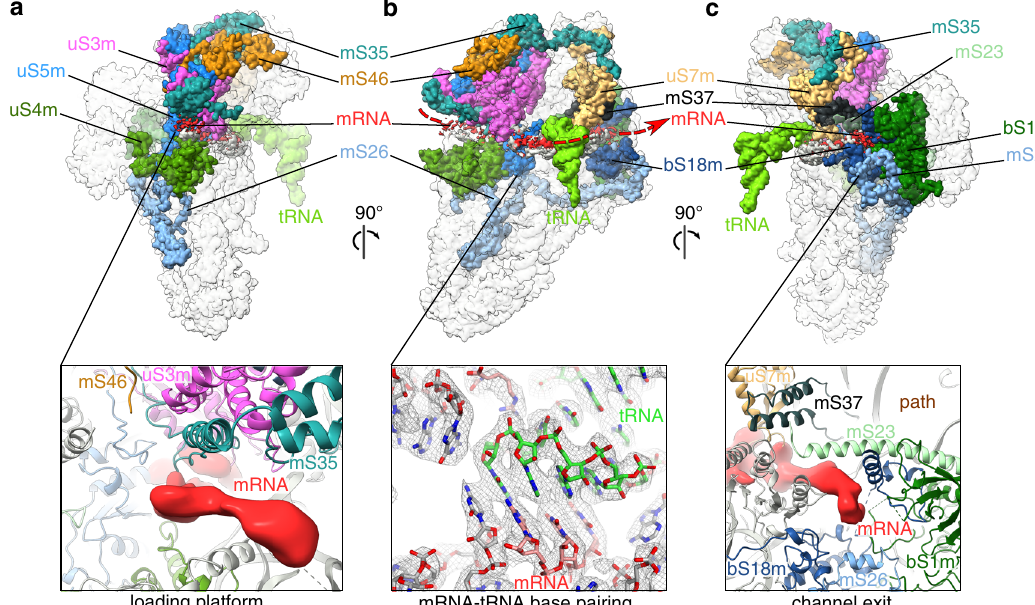
Fig. 2 The mRNA channel traced with the density. a The density for mRNA (red) reveals a protein platform formed by mS35, mS46 and extensions of uS3m and uS5m. b The overall path taken by mRNA is indicated based on the additional density associated with the mtSSU, and codon-anticodon base pairings at the decoding center shown with density. c At the exit site, proteins uS7m, bS18m, mS23, mS26, and mS37 are in contact with mRNA, and bS1m is permanently bound. A putative alternative path is